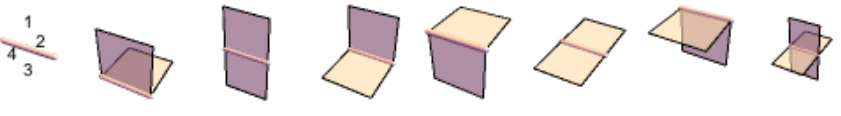
Figure 1: The configurations near an edge consistent with the fact that a domain wall has no